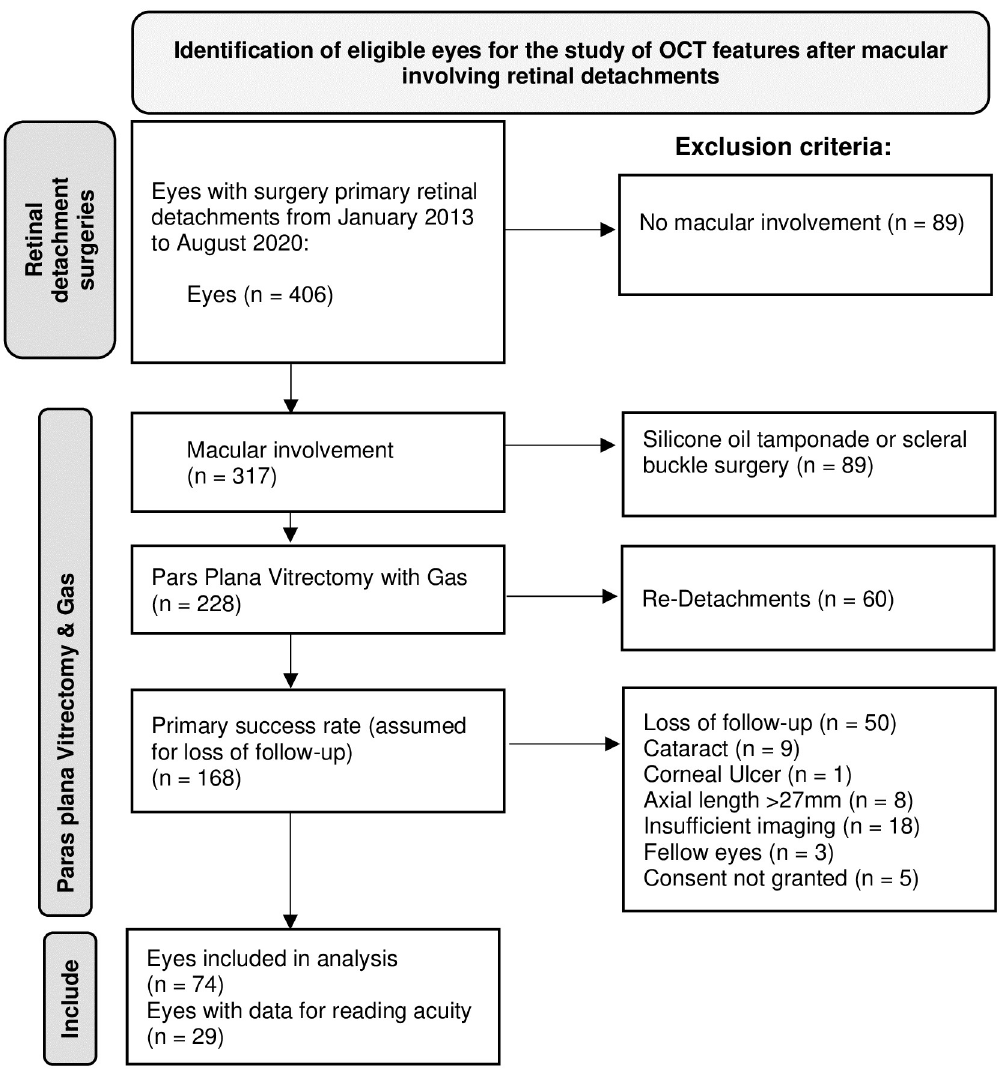
Fig 3. Inclusion and exclusion criteria. Flow chart illustrating the inclusion and exclusion criteria for analysis. Starting from a total of 406 eyes with primary rhegmatogenous retinal detachment from January 2013 to August 2020, 317 eyes showed macular involvement, and 228 of these underwent pars plana vitrectomy with SF6 or C3F8 gas endotamponade, with 168 primary successes after 6 months.